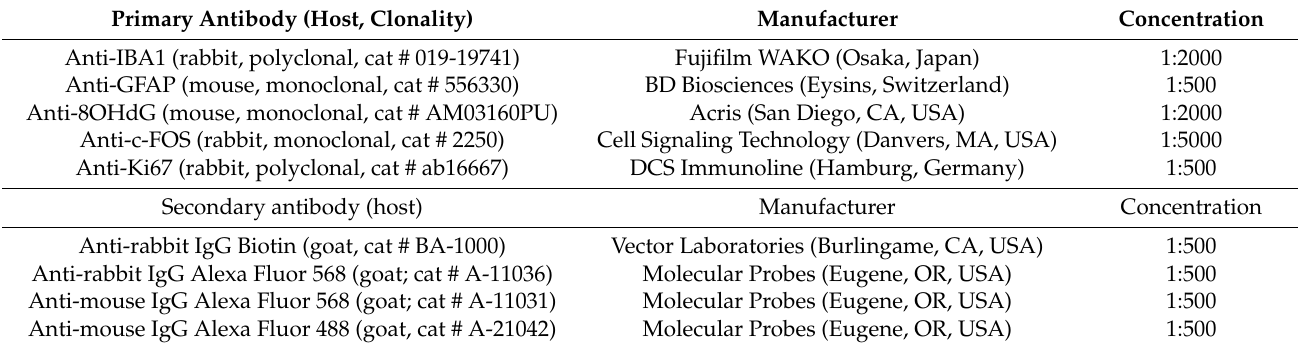
Table 2. List of antibodies used for immunohistochemistry and